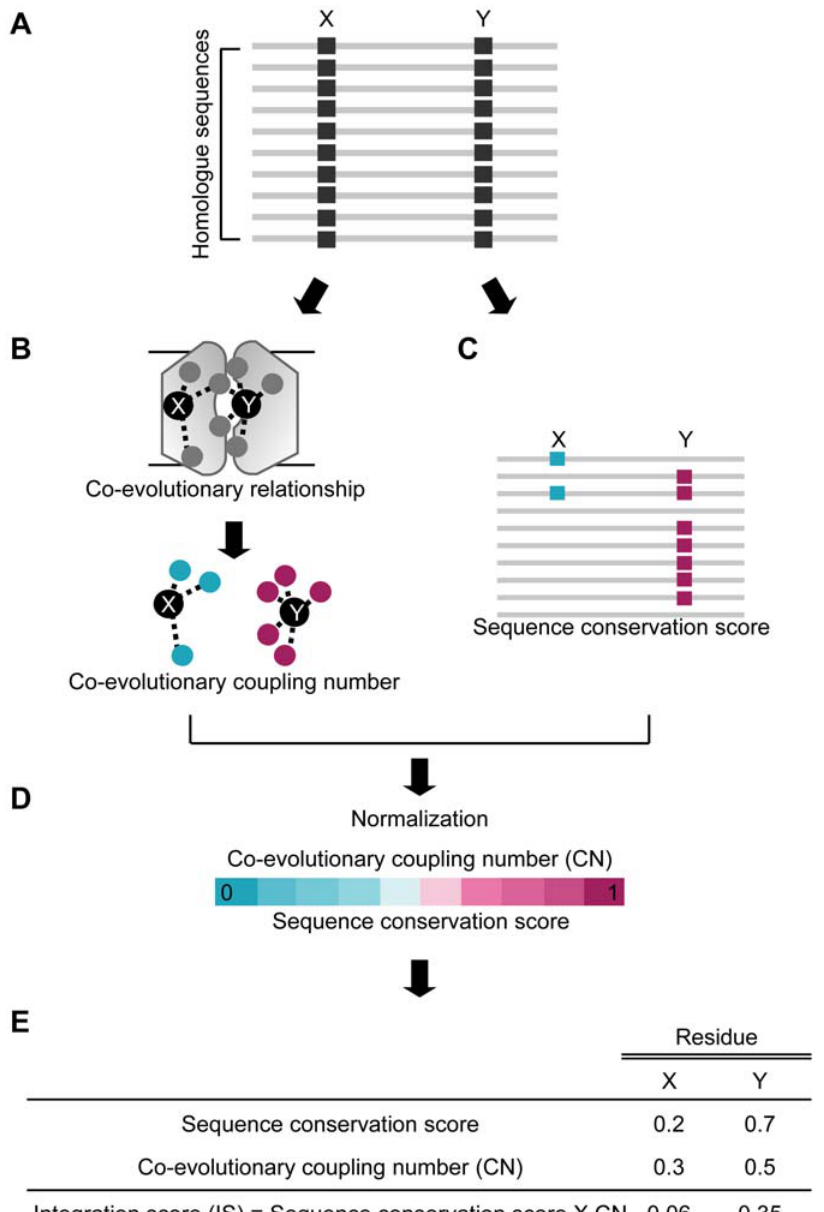
Figure 1. Overview of integrative evolutionary analysis. (A) A schematic view of multiple sequence alignment (MSA) of a protein family. Co- evolution and sequence conservation scores were calculated from homologue sequences. X and Y indicate different residues in a protein. (B) Quantification of the co-evolutionary relationship of a single residue. Co-evolutionary coupling number (CN) was defined by the number of co- evolved residue pairs per residue. A dashed line represents co-evolving residue pairs. Circles represent the co-evolved partners of residues X and Y. (C) Measurement of sequence conservation scores of residues X and Y. Blue and red squares indicate conserved amino acids of residues X and Y, respectively. (D) Normalization of CN and sequence conservation scores by assigning a score raging from 0 to 1. (E) Integration score (IS) was obtained by multiplying CN and sequence conservation score.